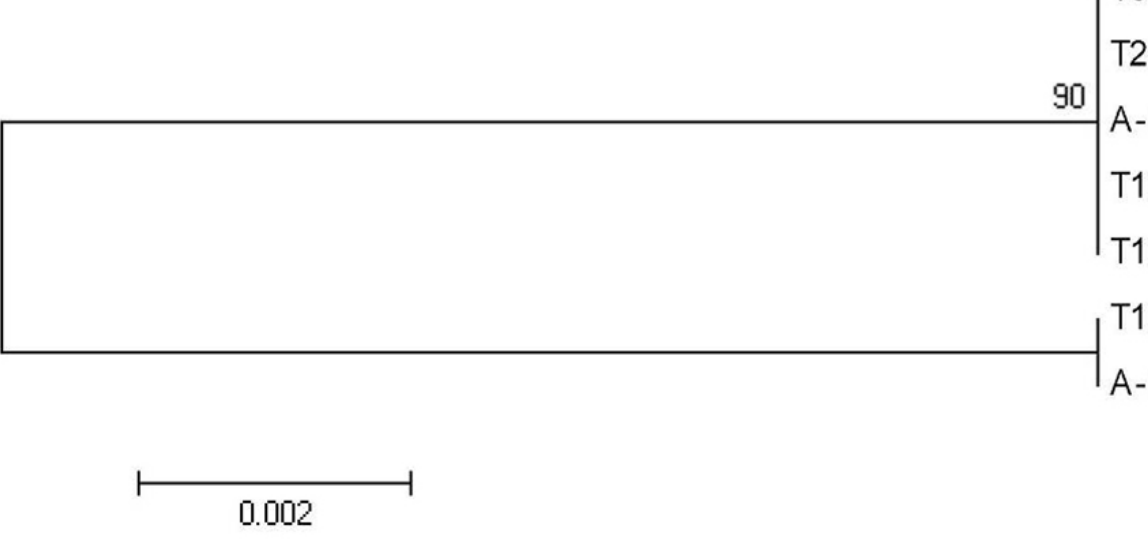
Figure 1. Neighbor-joining phylogenetic analysis of Giardia duodenalis axenic isolates at gdh locus. AI (L40509) and AII (L40510) correspond to sequences obtained in GenBank and T1, T2, T6, T10 and T11 correspond to the axenic isolates BTU-1, BTU-2, BTU-6, BTU-10 and BTU-11, respectively.